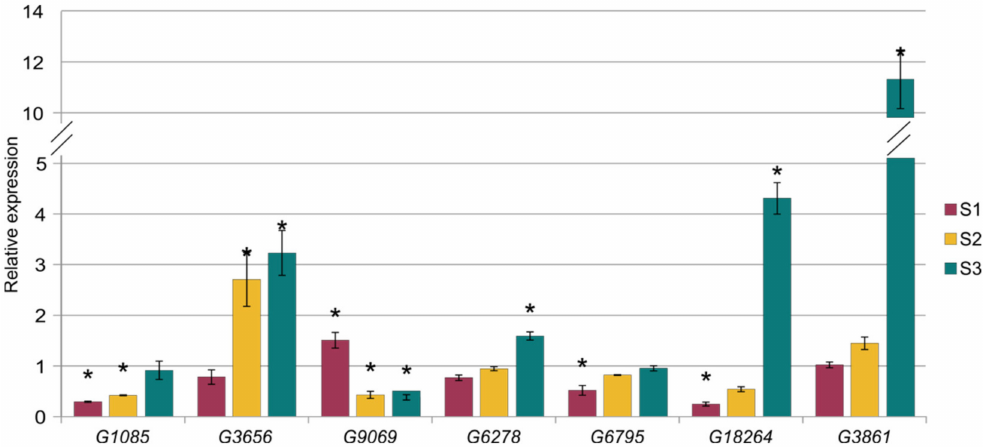
Figure 12. Results of the relative expression analysis of cucumber genes that are targets to the miRNA. Statistically important differences are marked with